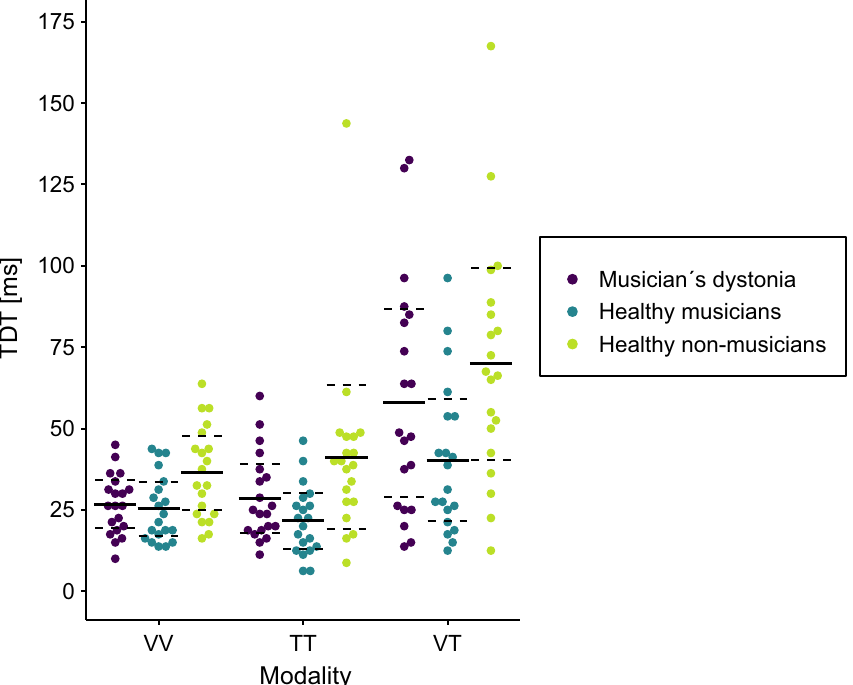
Figure 1. Visual (VV), tactile (TT) and visual-tactile (VT) temporal discrimination thresholds (TDT) in 20 patients with musician´s dystonia (purple), 20 healthy musicians (turquoise) and 20 healthy non-musicians (green). Solid lines represent the respective mean. Dashed lines indicate the 95% confidence interval of the